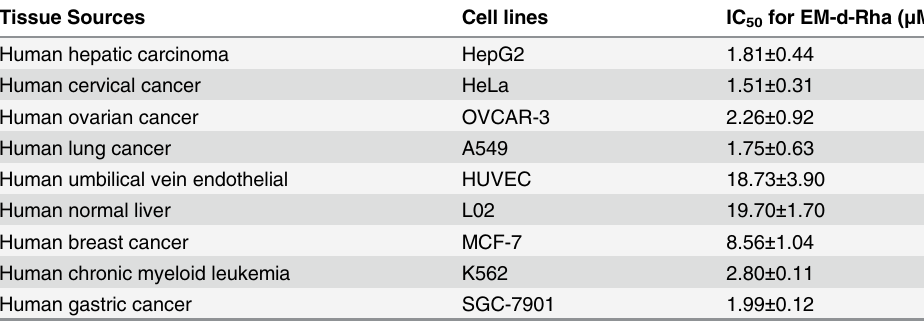
Table 2. IC50 values of EM-d-Rha against different cell lines.